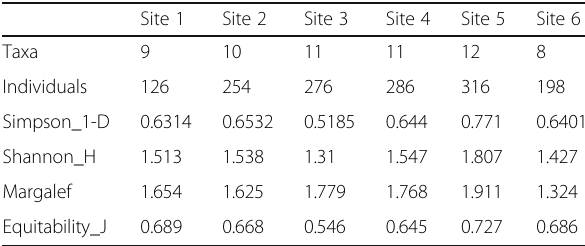
Table 4 Diversity of aquatic insects ’ community in Aahoo stream, Iloyin, Akure